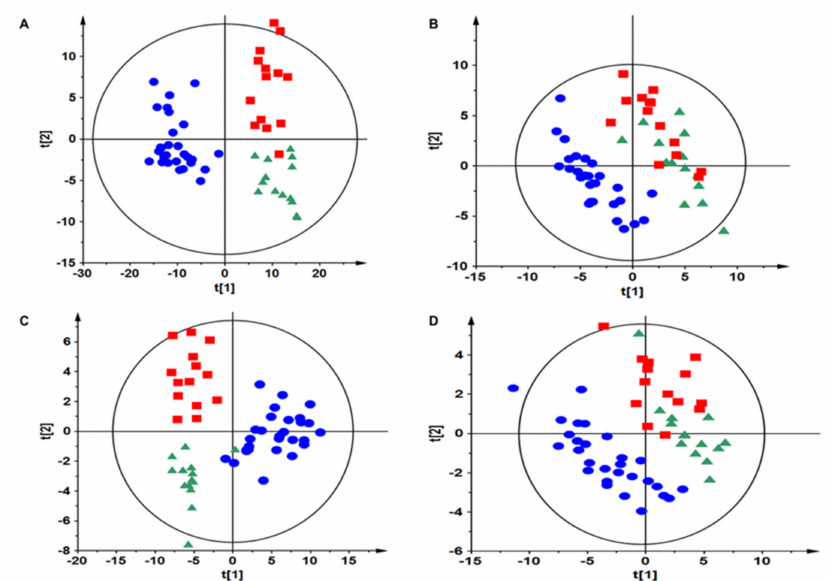
Figure 1. Discrimination between tumor and control tissue (early stage) as well as NSCLC sub- types based on lung tissue metabolic fingerprinting data. Data from RP and HILIC (ESI+ and ESI) methods were used to create these plots. PLS-DA plot showing discrimination between different NSCLC subtypes (ADC, SCC and control tissue (RP+)) is presented on panel ( A ) (Pareto scaling; cumulative values for six components: R 2 = 0.983, Q 2 = 0.853; p -value = 9.6 × 10 ( − 18) ). PLS-DA plot showing discrimination between different NSCLC subtypes (ADC, SCC and control tissue (RP − )) is presented on panel ( B ) (Pareto scaling; cumulative values for five components: R 2 = 0.93, Q 2 = 0.666; p -value = 2.2 × 10 ( − 15) ). PLS-DA plot showing discrimination between different NSCLC subtypes (ADC, SCC and control tissue (HILIC+)) is presented on panel ( C ) (Pareto scaling; cumulative val- ues for three components: R 2 = 0.858, Q 2 = 0.732; p -value = 1.7 × 10 ( − 21) ). PLS-DA plot showing discrimination between different NSCLC subtypes (ADC, SCC and control tissue (HILIC − )) is pre- sented on panel ( D ) (Pareto scaling; cumulative values for three components: R 2 = 0.72, Q 2 = 0.547; p -value = 4.1 × 10 ( − 7) ). ADC (green triangle), SCC (red square) and control (blue